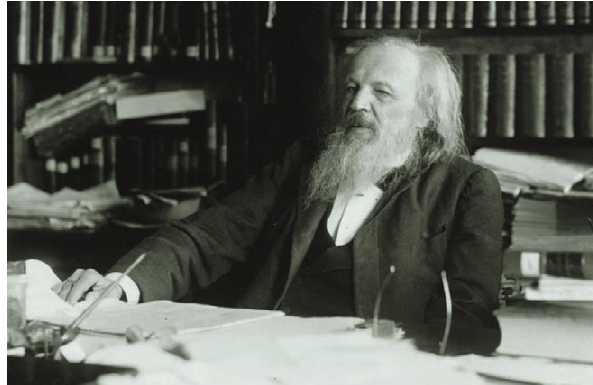
Figure 2. D. I. Mendeleev was the author and the main architect of the metrological reform in Russia (1892-1907). On his initiative, the Depot of Measures and Weights was transformed into a scientific metrological center – the Main Chamber of Measures and Weights (VNIIM since 1934). Photo from the collection of the Metrology Museum hosted by the D.I. Mendeleyev Institute for Metrology, 1904.